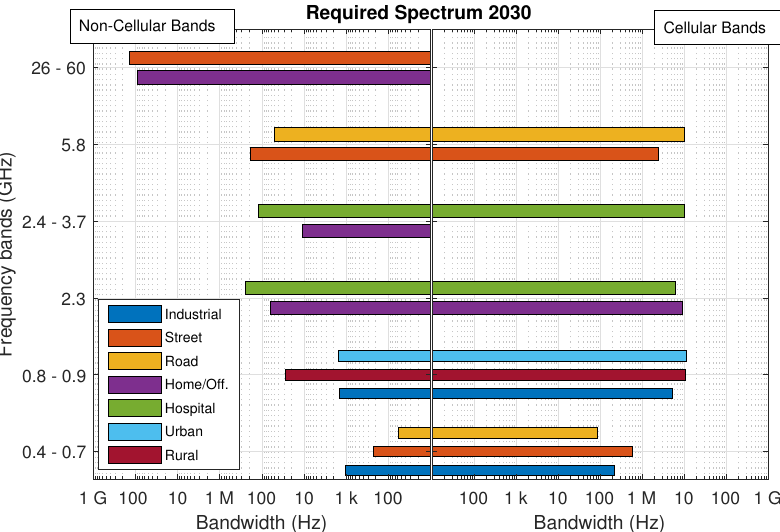
Figure 6. Required spectrum in 2030 dis-aggregation: frequency bands and